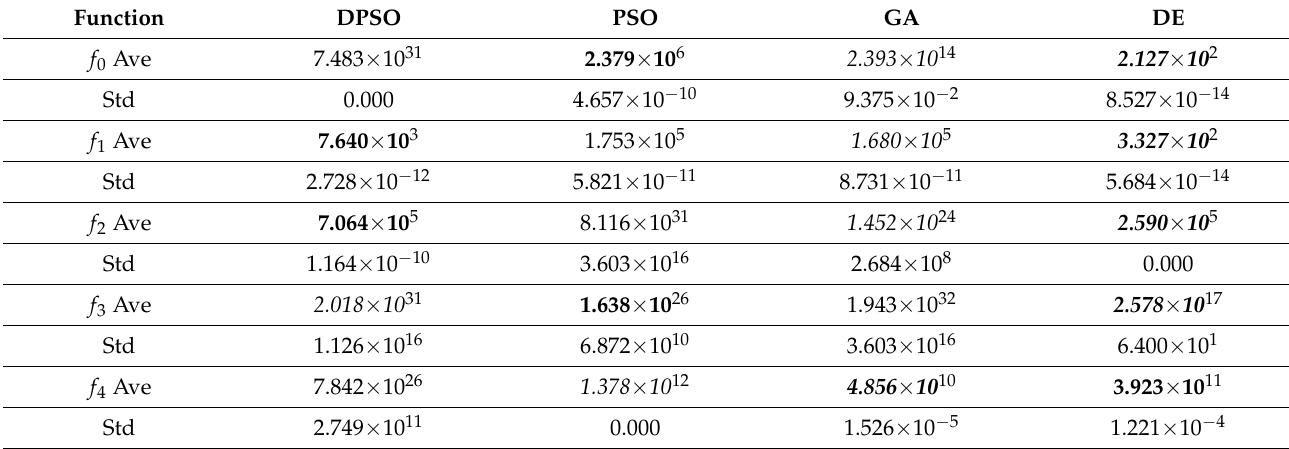
Table A5. Fitness w.r.t. each function problem with 14 dimensions and the resulting ranking: rank 1 (best) , rank 2 , rank 3 , and rank